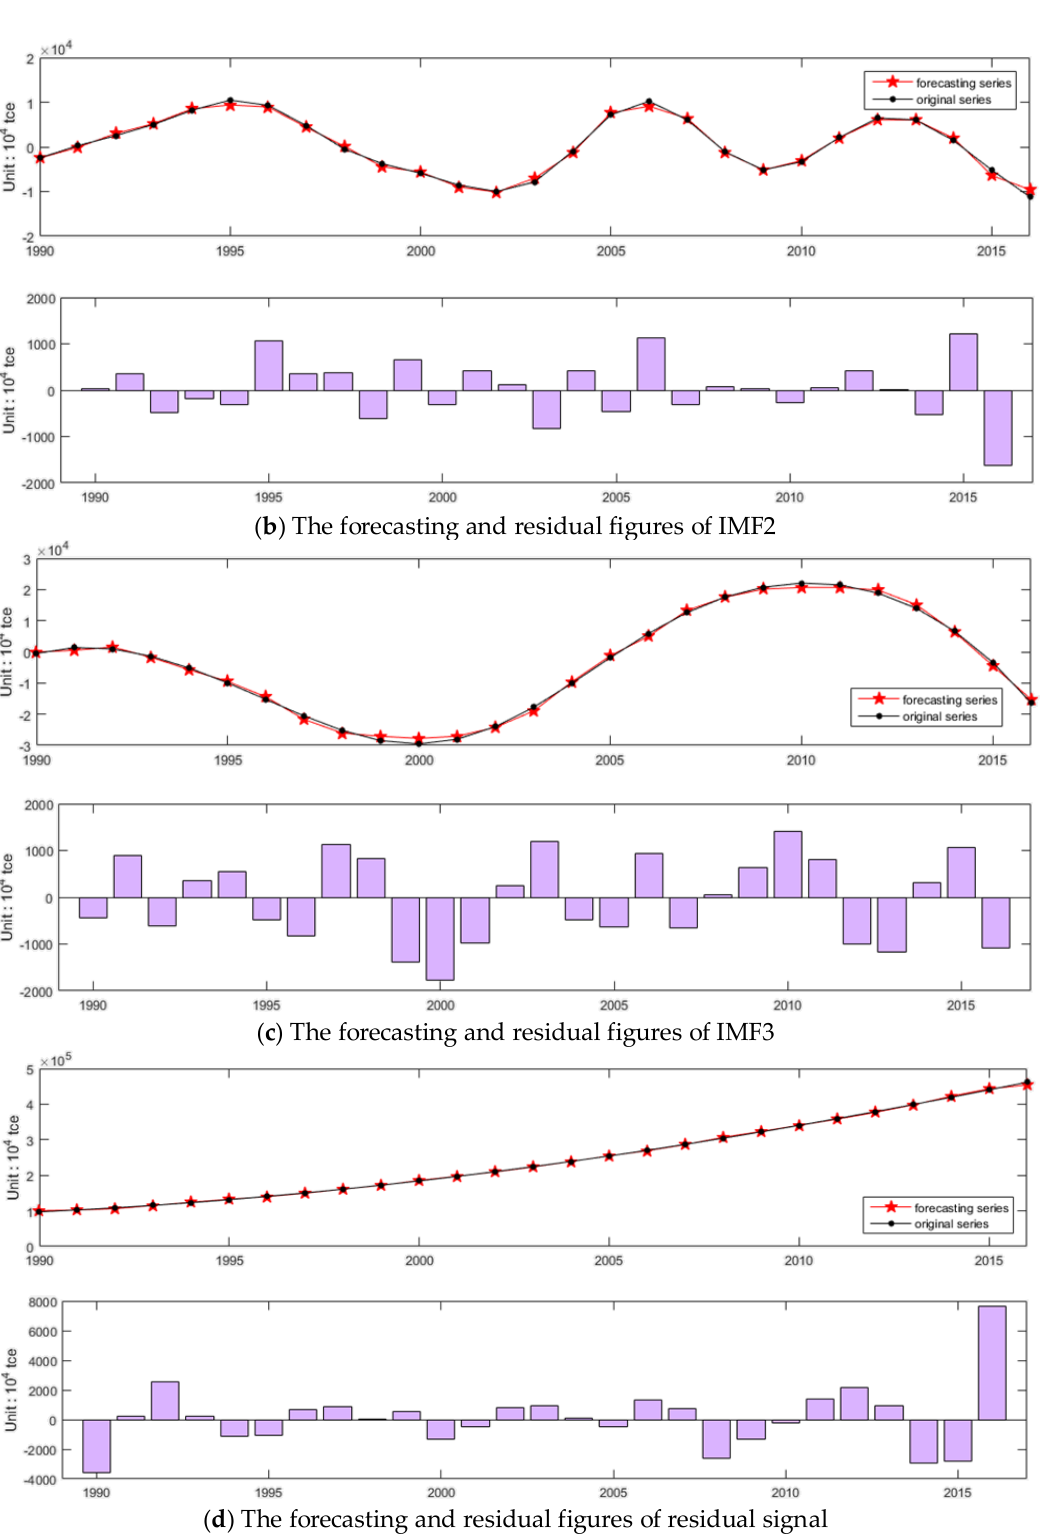
Figure 6. The forecasting results of IMFs.